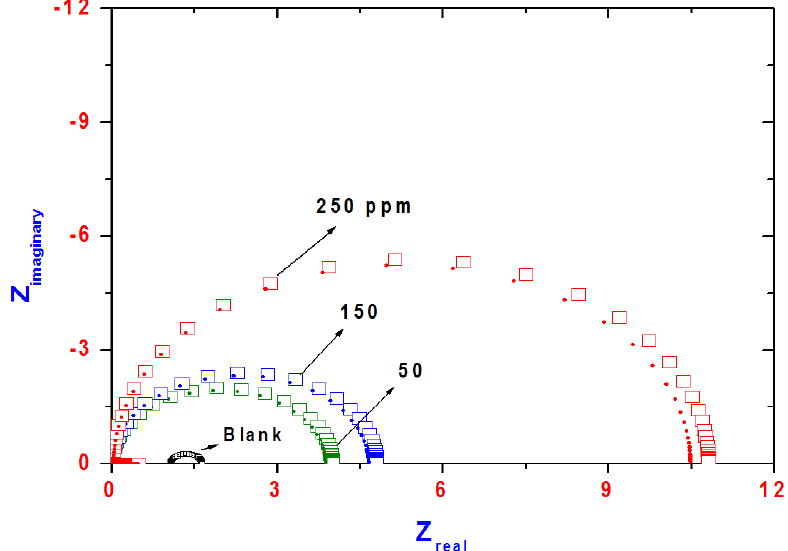
Figure 6. Nyquist plots for steel in 1 M hydrochloric acid solution containing different concentrations of AMPS/NIPAm-Ag NPs (square symbols represent experimental data and bold circles represent fitted